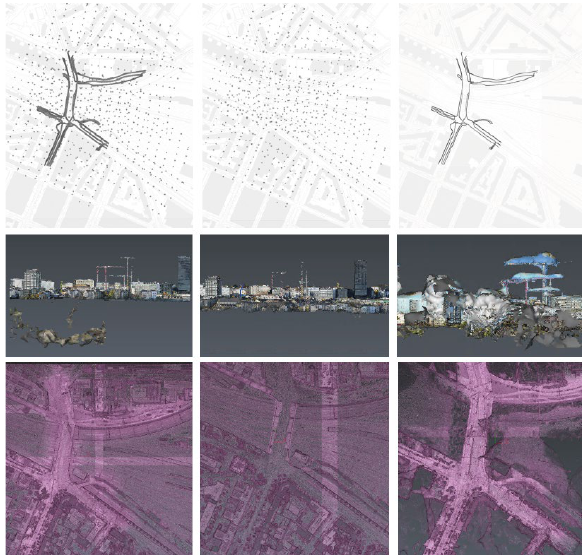
Figure 10. Illustrations of different 3D reconstructions of an identical sub-scene. Left: fusion UAV and MMS images, middle: UAV images only, right: MMS images only. From top to bottom: the distribution of the images on the plan, textured mesh front view, and a wireframe top view.